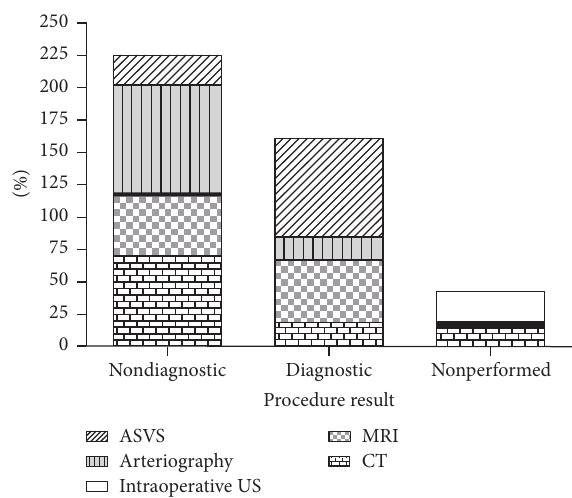
Figure 1: Diagnostic tests for the detection of